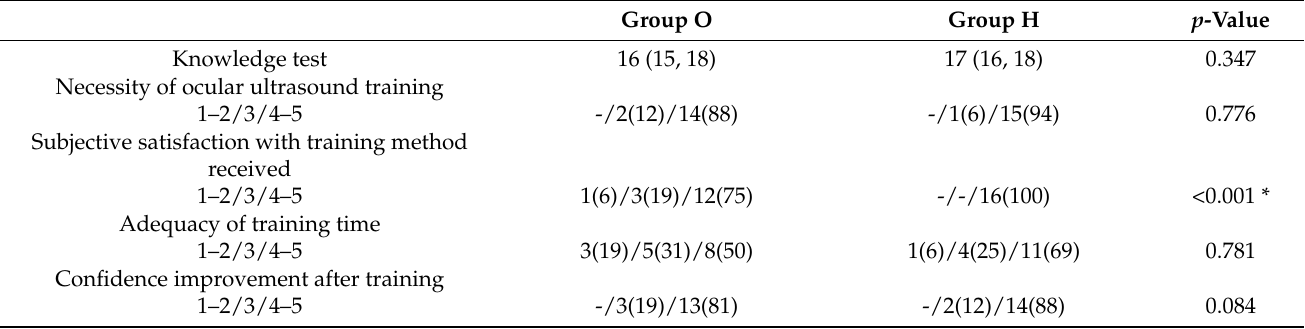
Table 4. The knowledge test and post-survey